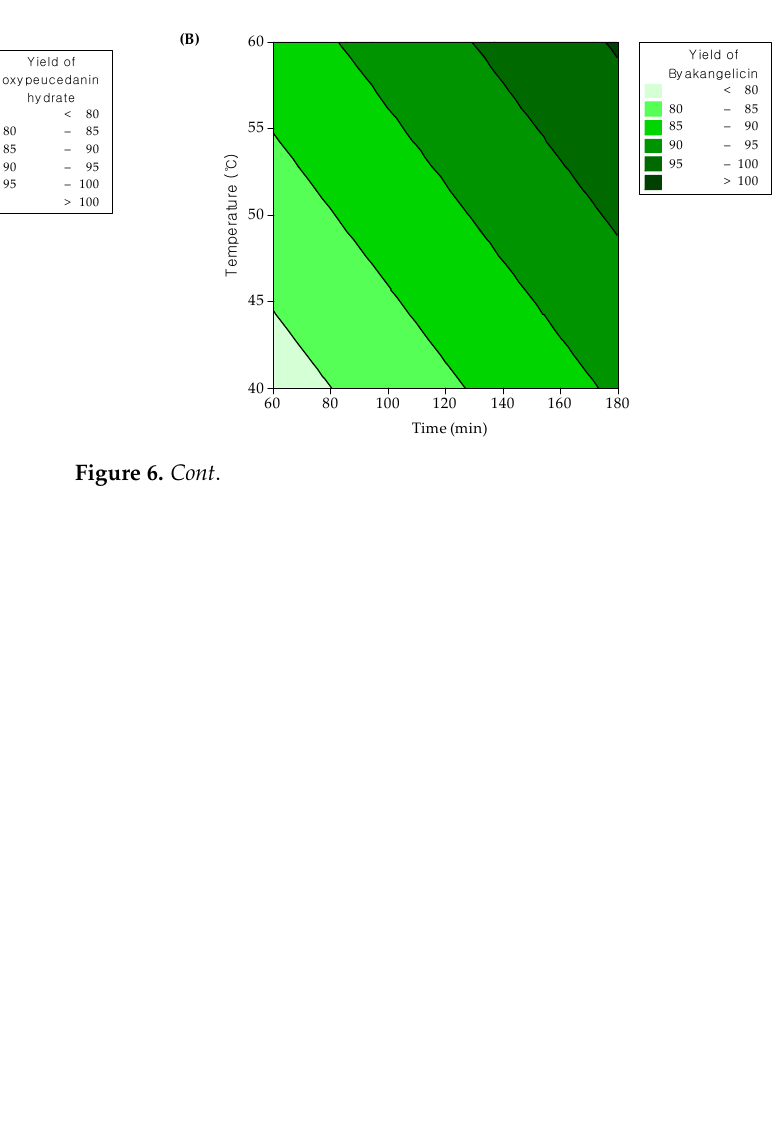
In Figure 6, the response surface plots indicating the interaction between param- eters and their effects on the extraction of oxypeucedanin hydrate and byakangelicin are displayed. The solvent/solid ratio of 8:1 at an extraction temperature of 60 ◦ C for 180 min were the optimum conditions proposed by RSM to improve the extraction yields of oxypeucedanin hydrate and byakangelicin up to 97.98% and 98.01%, respectively.